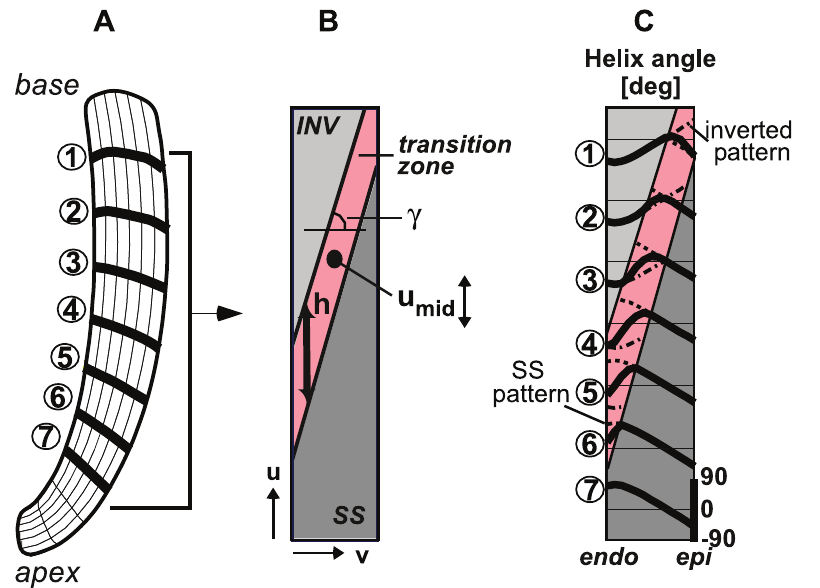
Figure 3. Initial myofiber orientation in SIT simulation MID . A : Long-axis cross-section of LV mesh. B : Mapping of the cross-section in A on a rectangular domain used to describe the spatial distribution of myofiber orientations. The transition from a normal (SS) pattern at the apex to an inverted (INV) pattern at the base is described by parameters u mid (location of transition at midwall), c (the slope of the transition between the endo- and epicardium), and h (the height of the transition zone). u mid is subject of variation in between the SIT simulations BASE , MID and APEX . C : Initial (before reorientation) transmural course of helix angle a h ,0 in simulation MID (solid) at the 7 levels indicated in A . In the transition zone, the courses of the SS ( 2 2 ) and inverted pattern ( 2 .) are presented. The transmural distribution of the transverse angle a t ,0 was set to